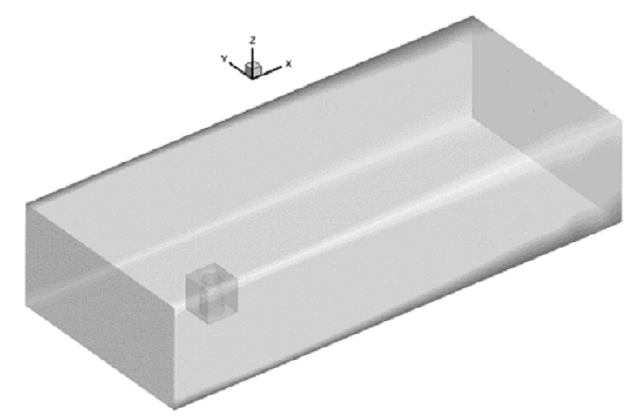
Figure 8. Computational domain considered for the proposed wind